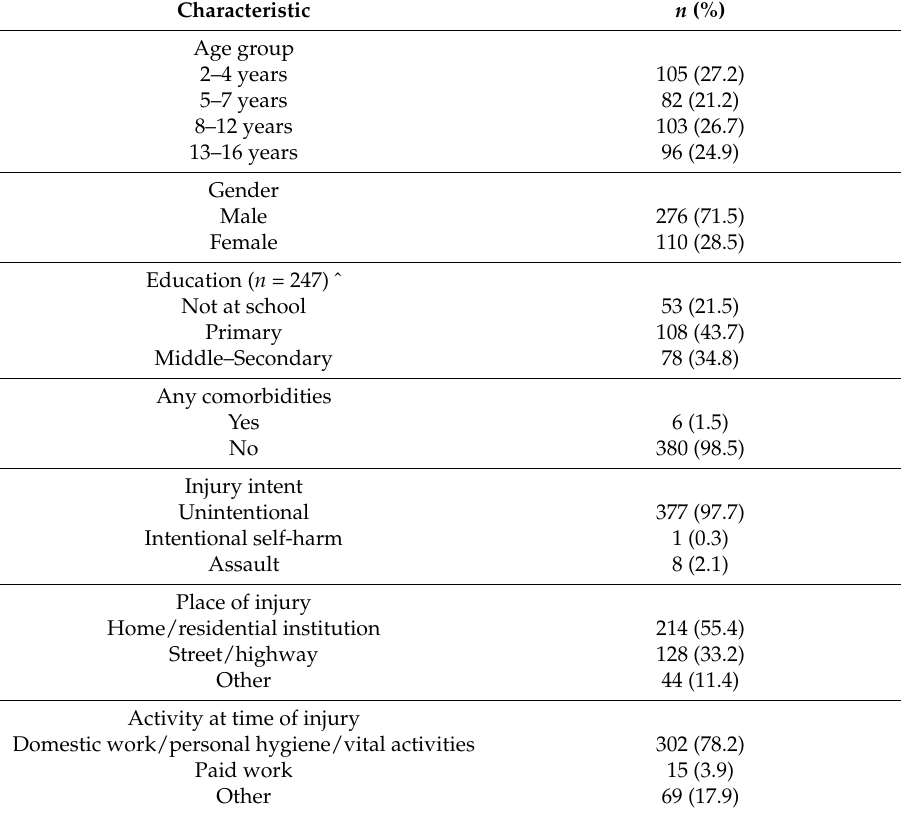
Table 1. Baseline characteristics of children aged 2–16 years ( n =